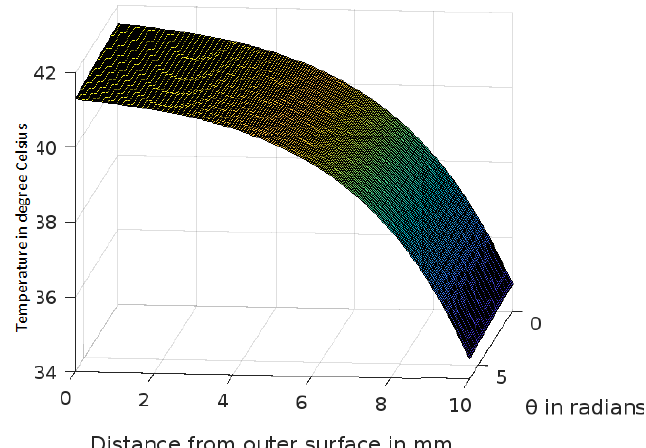
Figure 7. Variation of temperature profiles in human skin with an external temperature at the skin surface of 42 ◦ C.